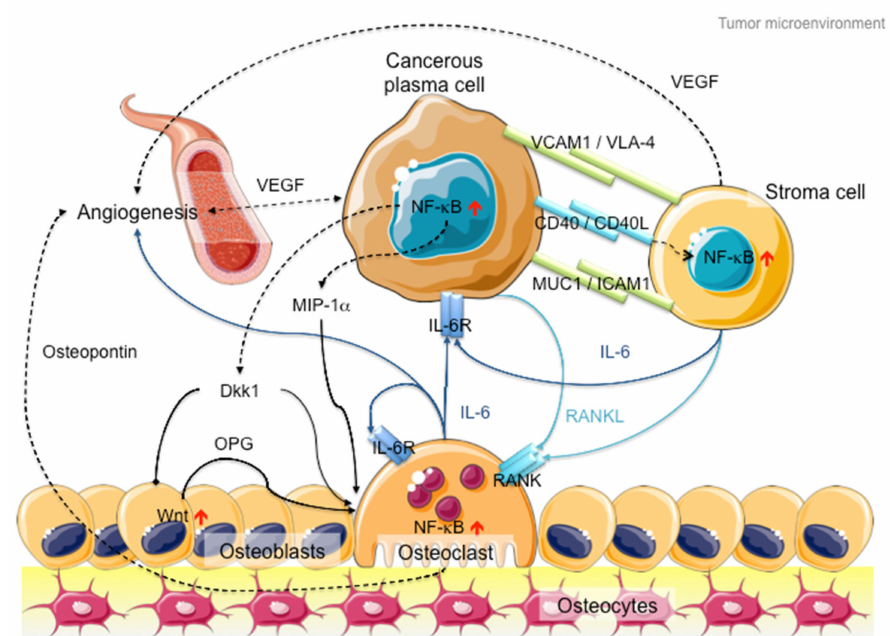
Figure2. SchematicdiagramoftheMMmicroenvironment. Cancerousplasmacellsinteractwithstroma, osteoblasts and osteoclasts through membrane receptor interactions and secretory cytokine pathways. Hyperactive NF- κ B signaling plays a pivotal role in disease progression through transcriptional activation of the secretion of various cytokines like IL-6, RANKL and Dkk1 to promote cancer cell proliferation, osteoblast inactivation, osteoclast hyperactivation and angiogenesis. Proteins involved in canonical NF- κ B signaling are indicated in dark blue, whereas proteins involved in non-canonical NF- κ B signaling are indicated in light blue. Arrows with triangle heads indicate activation, whereas arrows with rhomboid heads indicate inactivation / inhibition; direct interactions are indicated by solid lines, whereas indirect interactions are indicated by dashed lines. Artistic images were